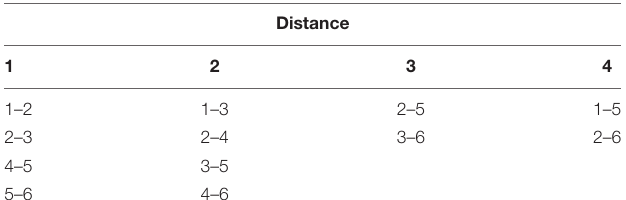
TABLE 1 | Comparison pairs for the different numerical